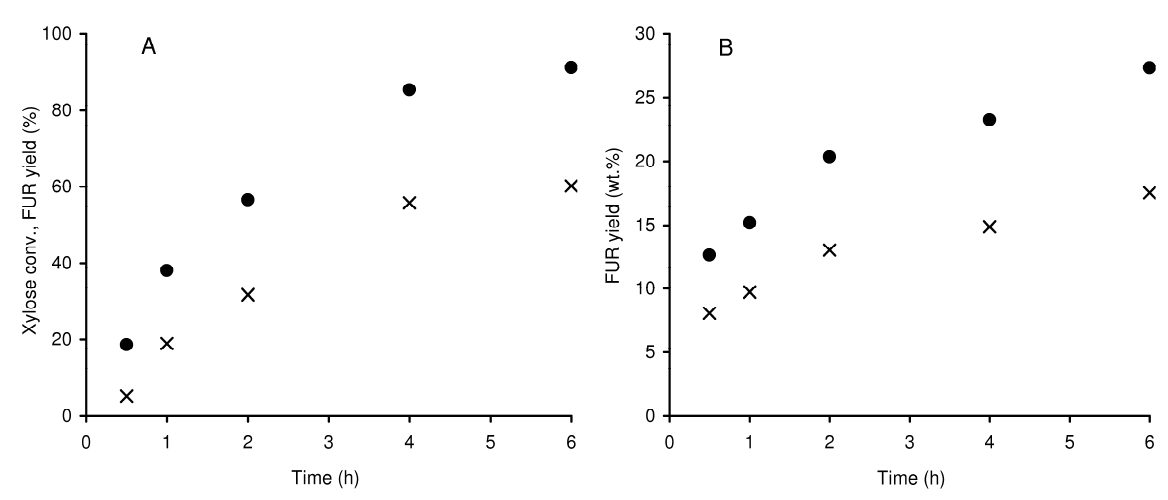
Figure 7. Reaction of xylose (A: ( ● ) conversion; ( × ) FUR yield), and reaction of xylan (B: ( ● ) xylose yield; ( × ) FUR yield), in the presence of Al-TUD-1 at 170